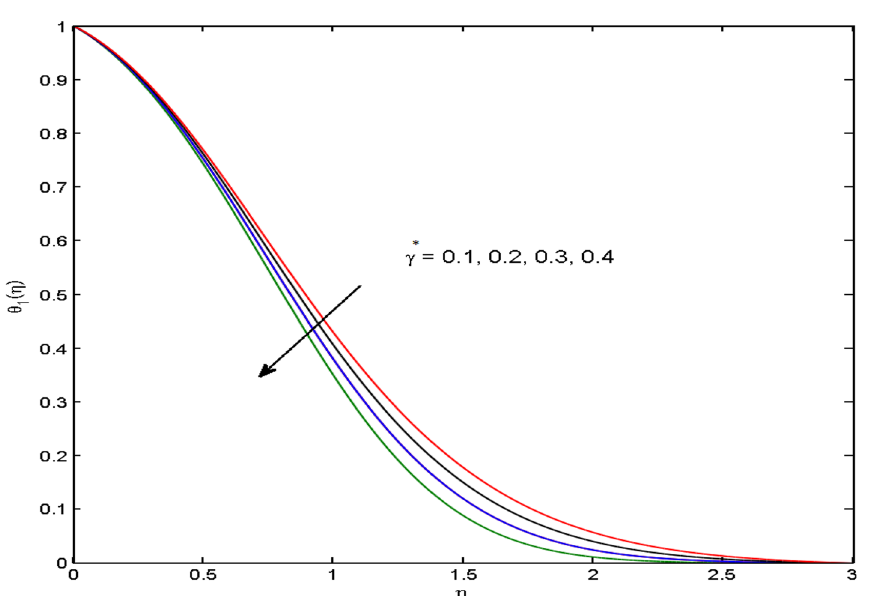
Figure 8. θ 1 (η) versus varied estimates of γ ∗